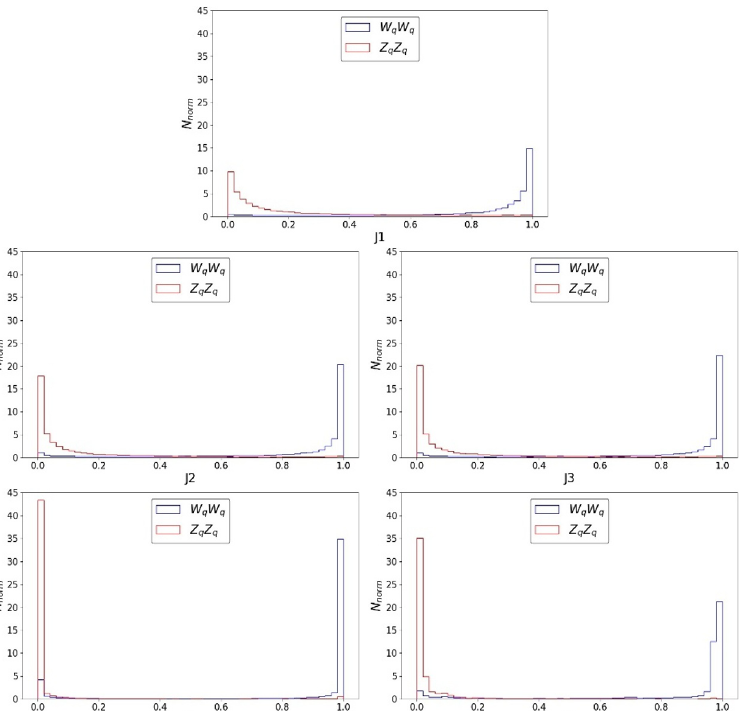
Figure 14 . Response of the W q W q and Z q Z q events to J1, J2, J3, E1 and E2